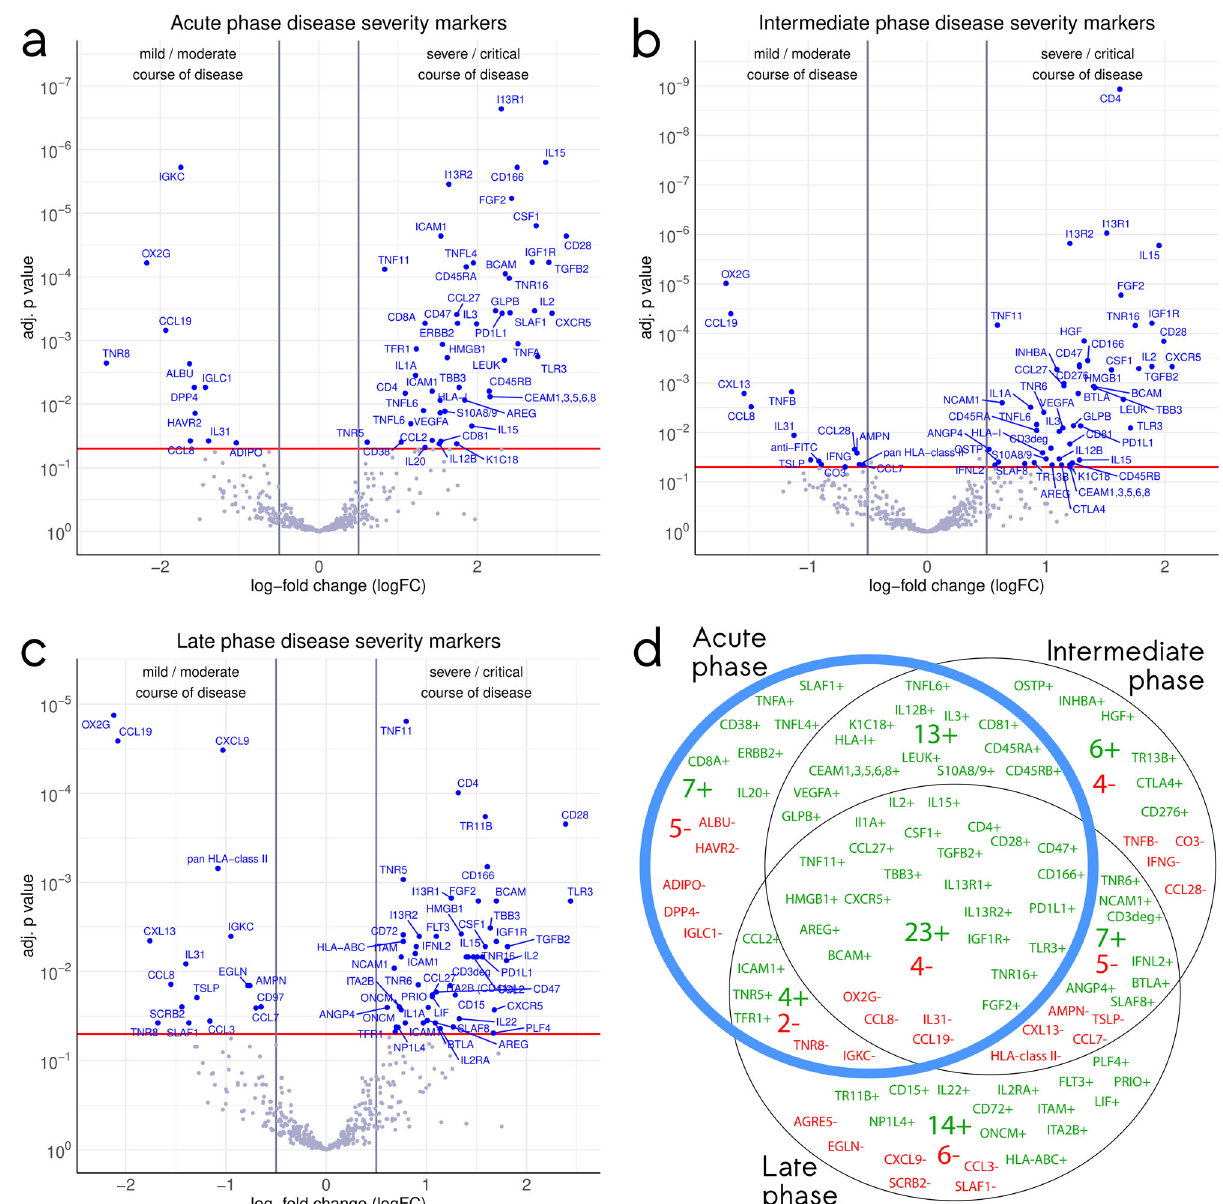
Fig. 2 Venn diagram and volcano plots illustrating the number, degree and signi fi cance of differential protein expression in the 1 st cohort. The volcano plots visualize the p values (adjusted for multiple testing) and corresponding log-fold changes (logFC) of the identi fi ed protein biomarker candidates. A signi fi cance level of adj. p value = 0.05 is indicated as a horizontal red line. Absolute logFC cutoffs of |logFC| > 0.5 are indicated as vertical lines. 53 plasma samples from 16 COVID-19 patients were analyzed and divided into an acute ( a ) an intermediate ( b ) and a late stage ( c ), for which we included 18, 20 and 16 samples, respectively. Proteins with a positive logFC had a higher abundance in CS samples, proteins with a negative value in MM samples. d : Venn diagram listing the differential proteins and their numbers in the respective phases. Green numbers and protein IDs indicate proteins more abundant in CS patients and red numbers and IDs proteins with higher abundance in MM